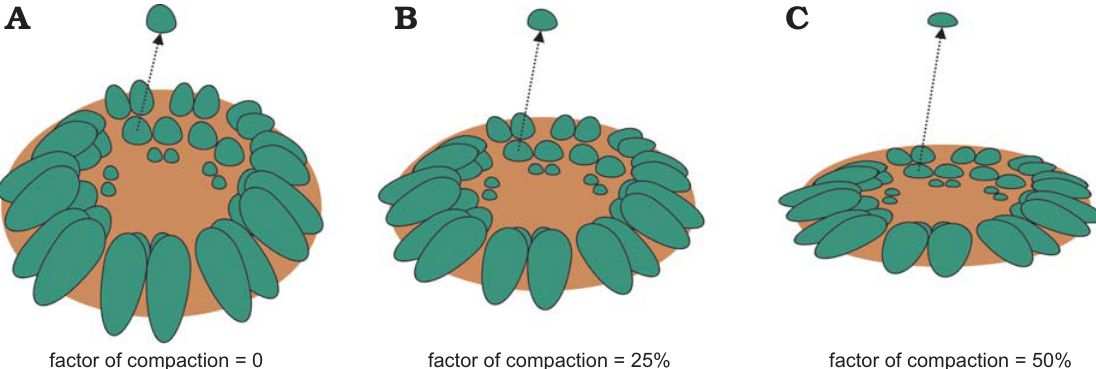
Fig. 2. A schematic illustration of an oviraptorid clutch affected by different degrees of compaction. A . Original configuration. B . The same configuration affected by a compaction factor of 25%. C . The same configuration affected by a compaction factor of 50%. Note the change of inclination angle and shape of the